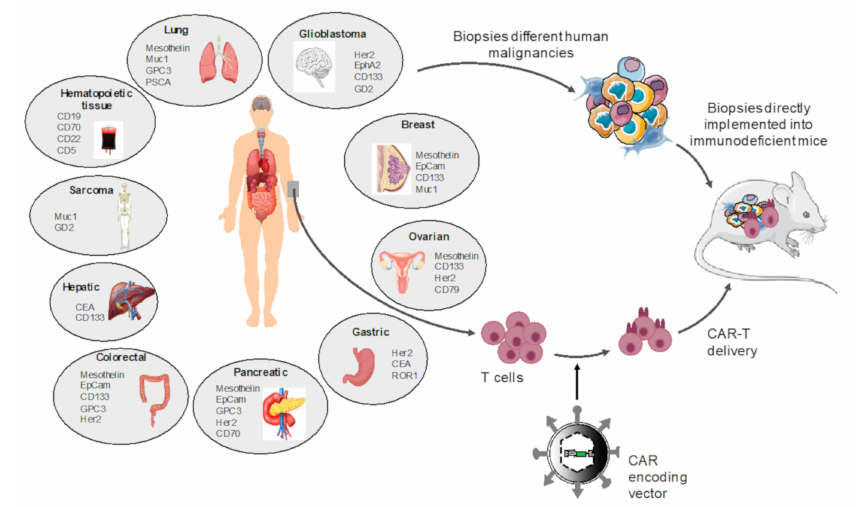
Figure 3. Patient-derived-xenograft mice for CAR T cell evaluation. Patient tumor biopsies are injected into NSG mice and subsequently T cells from the same patient are modified using a vector encoding